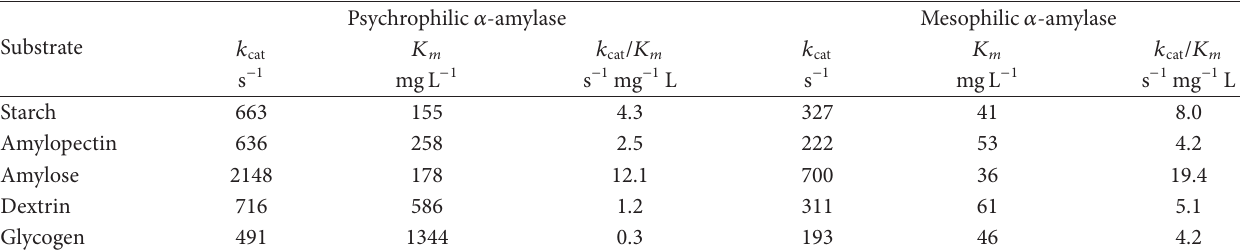
C by psychrophilic and mesophilic ○